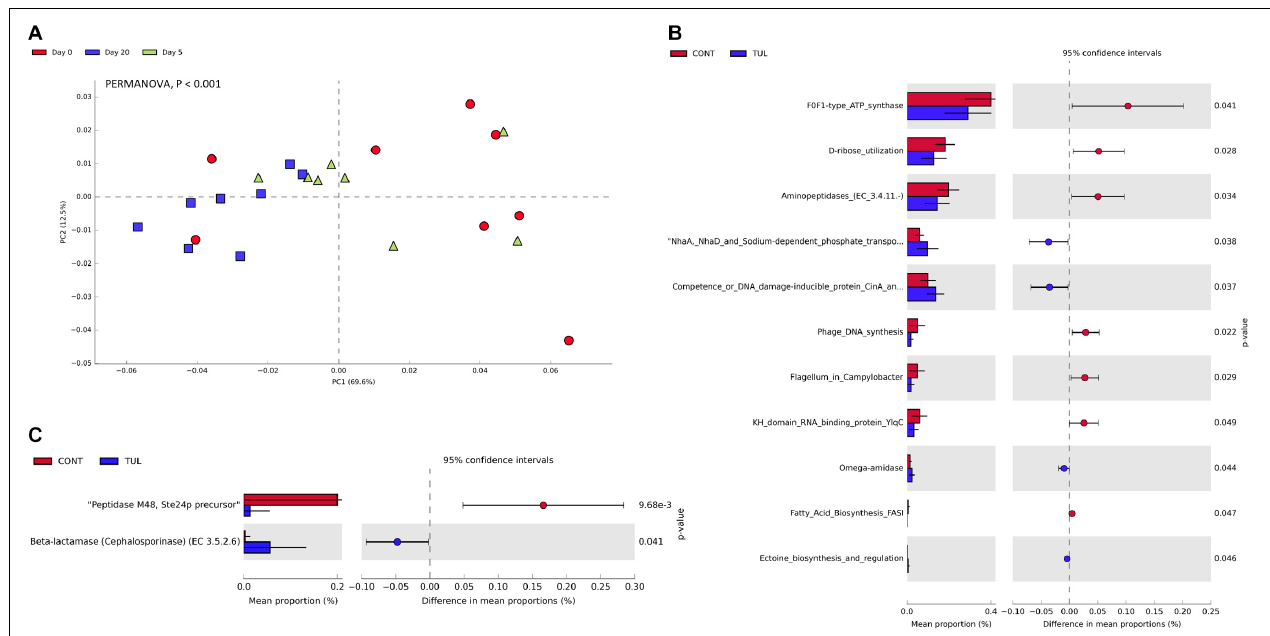
FIGURE 6 | (A) Principal component analysis (PCA) for the predicted functional profiles at level 3 across all samples at different sampling days (0, 5, and 20). The percent variation explained by each component is indicated on the axes. Significance between groups was analyzed using PERMANOVA with 9999 permutations and Bonferroni corrected P- values. (B) Extended bar plot showed the statistically significant difference in functional gene features in the tulathromycin (TUL) piglets compared to the control (CONT) group. P -value < 0.05 was considered significant. (C) Extended bar plot showed the statistically significant difference in the resistance to antibiotics functional genes in the tulathromycin (TUL) piglets compared to the control (CONT) group. P -value < 0.05 was considered significant.